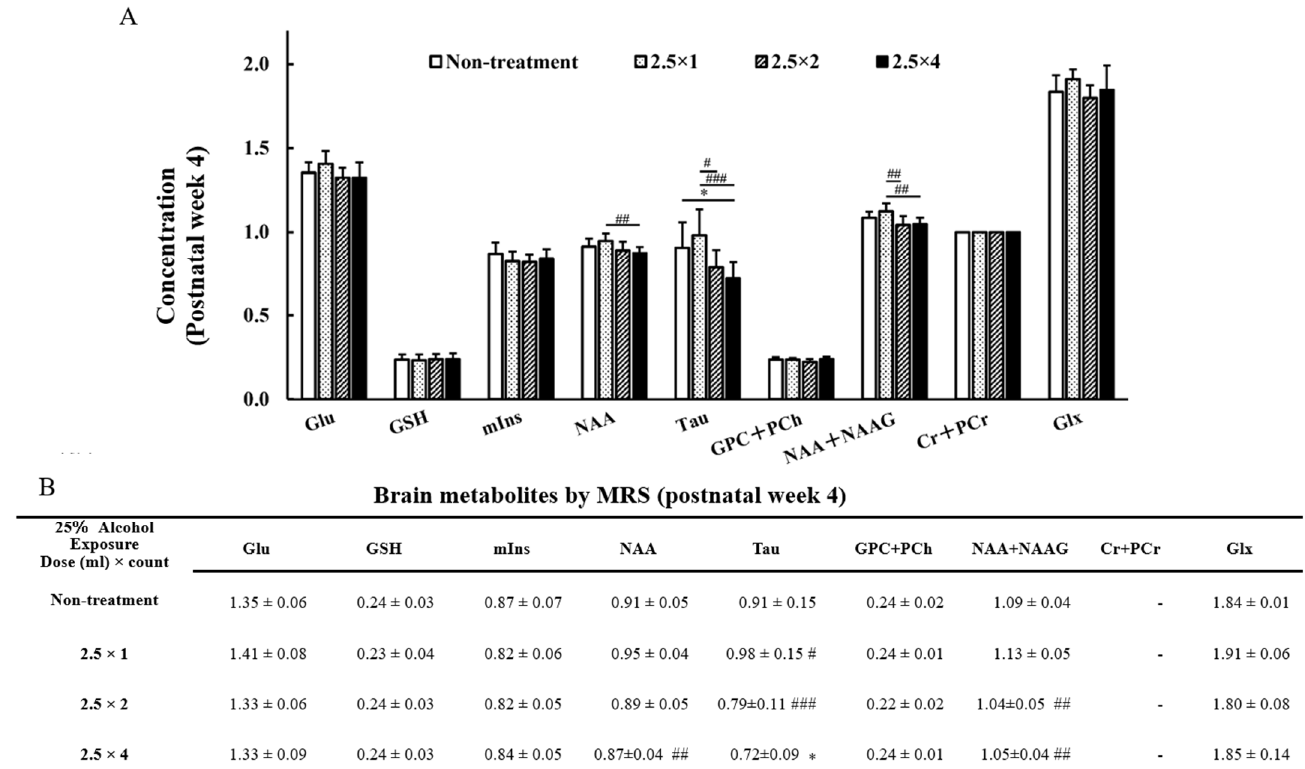
Figure 6. Graph ( A ) and Table ( B ) of brain metabolites on MRS at 4 weeks of age: glutamine (Glu), glu- tathione (GSH), Myo-inositol (mIns), N-acetyl aspartate (NAA), Taurine (Tau), glycerophosphocholine + phosphocholine (GPC + PCh), N-acetyl aspartate + N-acetyl aspartyl glutamate (NAA + NAAG), creatine + phosphocreatine (Cr + PCr), and glutamine + glutamic acid (Glu + Gln). The results of the comparison between the four-groups (non-treatment, 2.5 × 1, 2.5 × 2, and 2.5 × 4) are shown. Between-group comparisons were analyzed by one-way ANOVA with Tukey’s multiple compari- son tests using Prism 9. The results showed no significant difference between the two-dose group (2.5 × 2) and the four-dose group (2.5 × 4). As compared with the non-treatment group: * p <